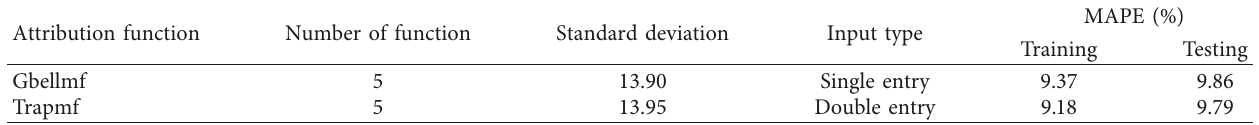
Table 5: Results of the test group data into the ANFIS.